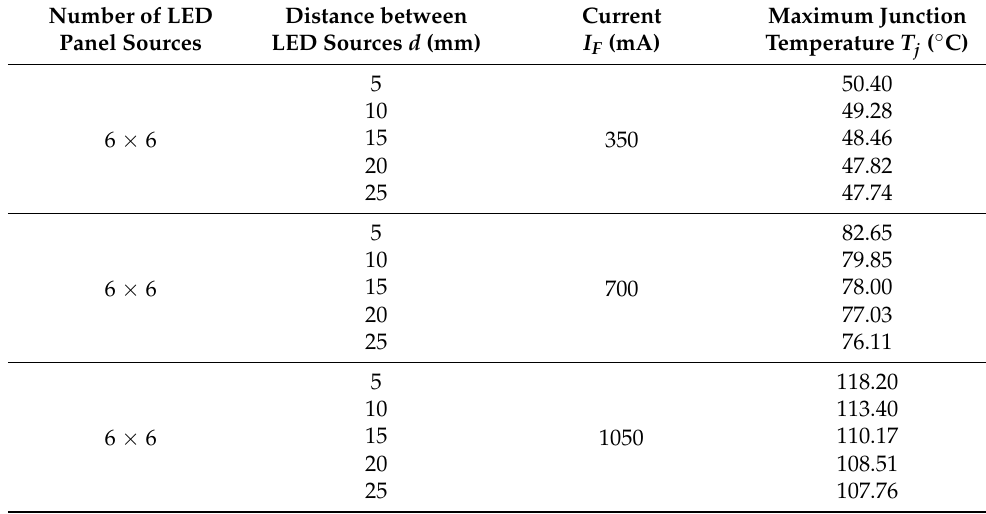
Figure 14. Temperature distribution of LED panels along the axis with the maximum temperature T j of installed LEDs for different distance between them: ( a ) I F = 350 mA, ( b ) I F = 700 mA, ( c ) I F = 1050 mA. Table 3 summarizes the maximum junction temperature of the LED sources for all tested distances between the LED sources. Table 3. Maximum junction temperature for a panel with variable distance between LED